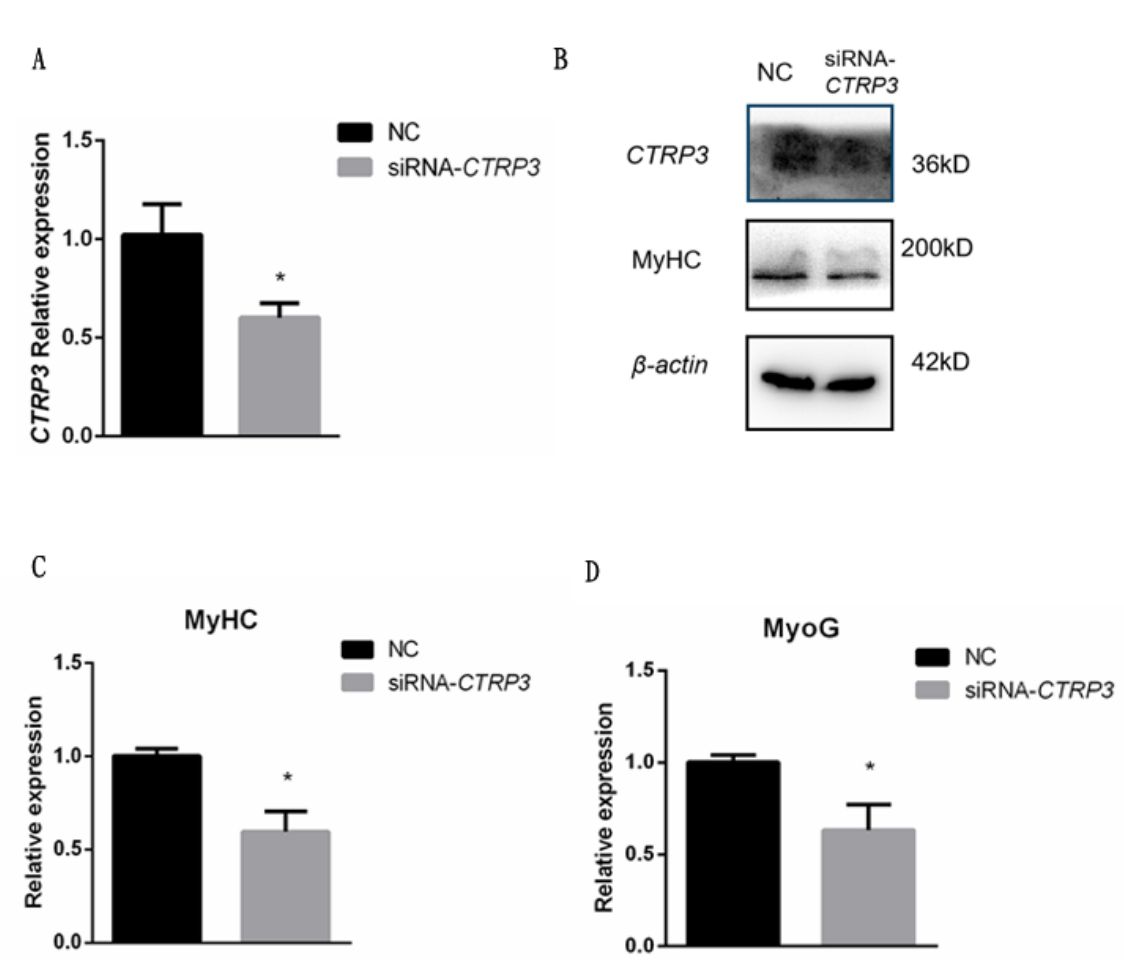
Figure 4. Knockdown of CTRP3 inhibited the expression of MyHC and MyoG during differentiation. (A) The mRNA level of CTRP3 was detected by qPCR in myoblast transfected with siRNA- CTRP3 or NC at day 3 of DM. (B) The protein levels of CTRP3 and MyHC were detected by western blot in myoblast transfected with siRNA- CTRP3 or NC at day 3 of DM. (C) The mRNA level of MyHC was detected by qPCR in myoblast transfected with siRNA-CTRP3 or NC at day 3 of DM. (D) The mRNA level of MyoG was detected by qPCR in myoblast transfected with siRNA- CTRP3 or NC at day 3 of DM. Results are expressed as mean±standard error of the mean (n = 3). * p<0.05. CTRP3 , C1q and tumor necrosis factor-related protein 3; MyHC , myosin heavy chains; MyoG , myogenin; qPCR, quantitative polymerase chain reaction; NC, negative control; DM, differentiation